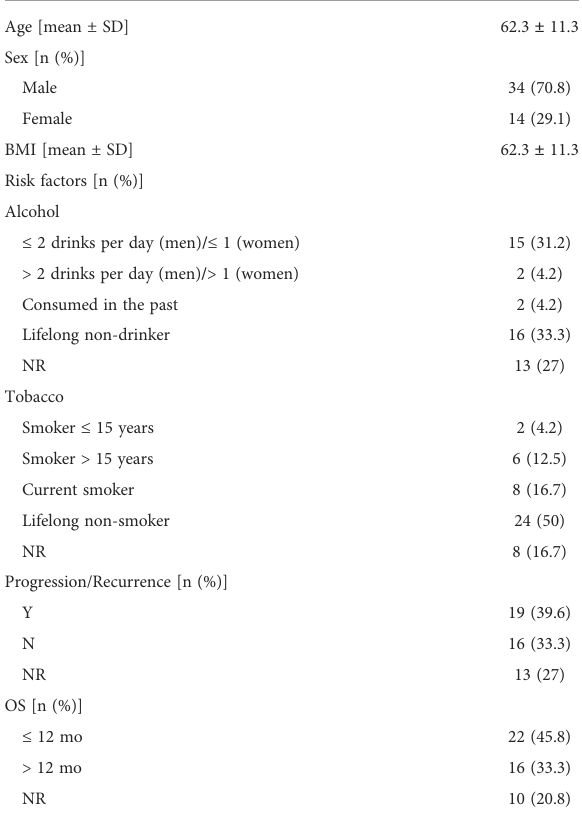
TABLE 1 Clinical and pathologic characteristics of the included patients. Clinical and pathologic